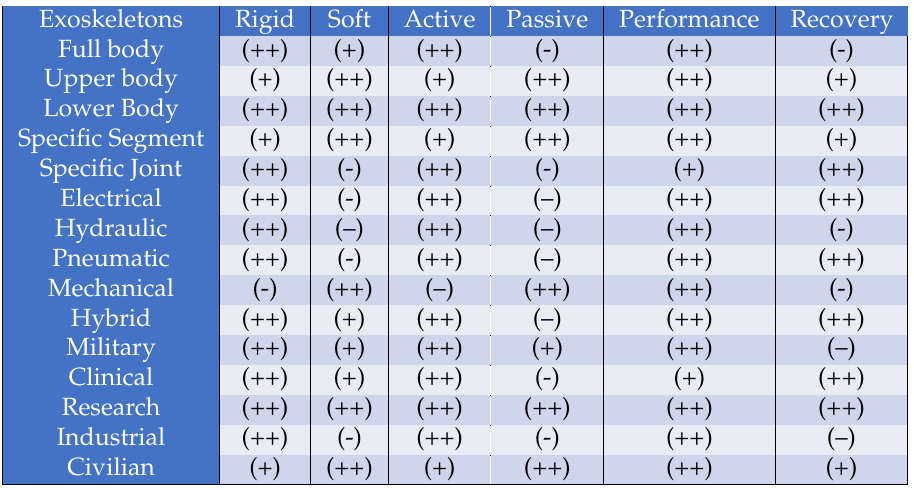
Table 3. This table is comparing different classes of the exoskeletons and grading them with a recommendation